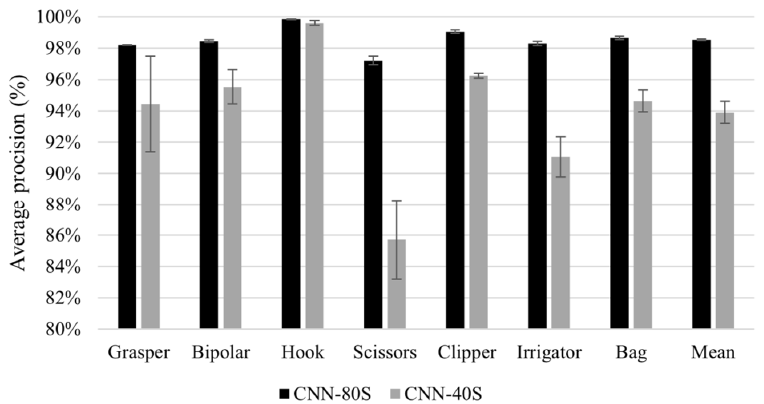
Figure 4. Results of generalisation to new subjects. Average precision of tool presence detection for all tools yielded by CNN-80S model (back bars) and CNN-40S model (grey bars). Note the truncated scale of the y -axis.